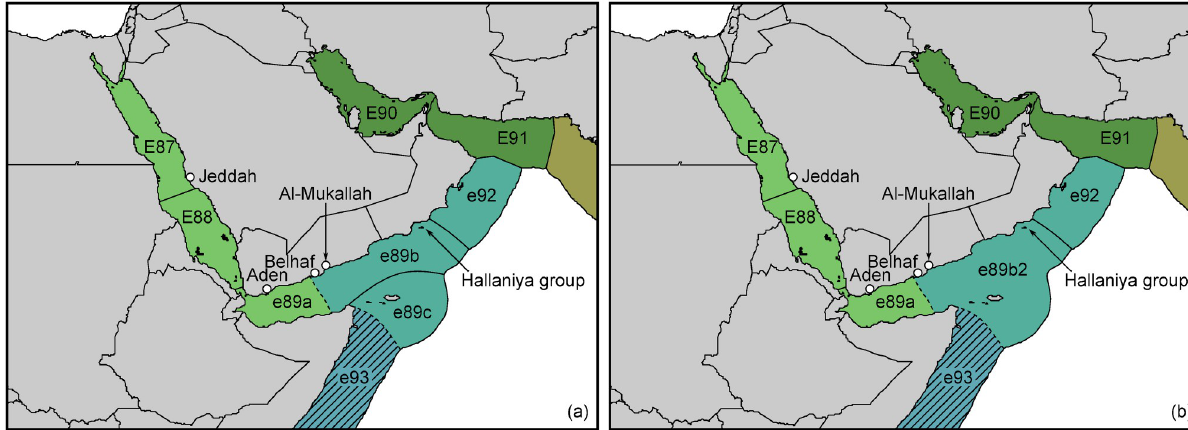
Fig 9. Provisional alternative delineations of Arabian ecoregions and provinces, modifying Spalding et al. (2007) by (a) tripartitioning ecoregion E89, designating the Socotra Archipelago a distinct ecoregion (e89c) besides the Western (e89a) and extended Eastern Gulf of Aden (e89b), and modifying ecoregion E92 (and a slight modification of ecoregion E93); (b) bipartitioning ecoregion E89 into a Western Gulf of Aden (e89a) and a common ecoregion for the extended Eastern Gulf of Aden and Socotra (e89b2), and modifying ecoregion E92 (amended provinces are indicated by shared colours, and boundary delineations that require further confirmation are indicated by dashed lines). (a, b: Baseline map sourced 2019 from Natural Earth, free vector and raster map data < naturalearthdata.com > with no copyright restrictions. Ecoregion boundaries redrawn and partly modified from GIS data accompanying Spalding et al. (2007), sourced 2012 from < conserveonline.org > , with free permission for scientific use and reproduction (to date only available from < worldwildlife.org > ), colours modified).